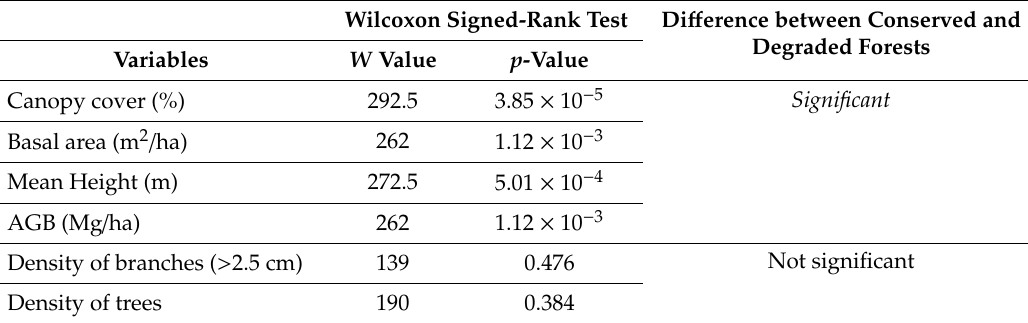
Table 2. Results of Wilcoxon signed-rank test for forest variables ( p -value <